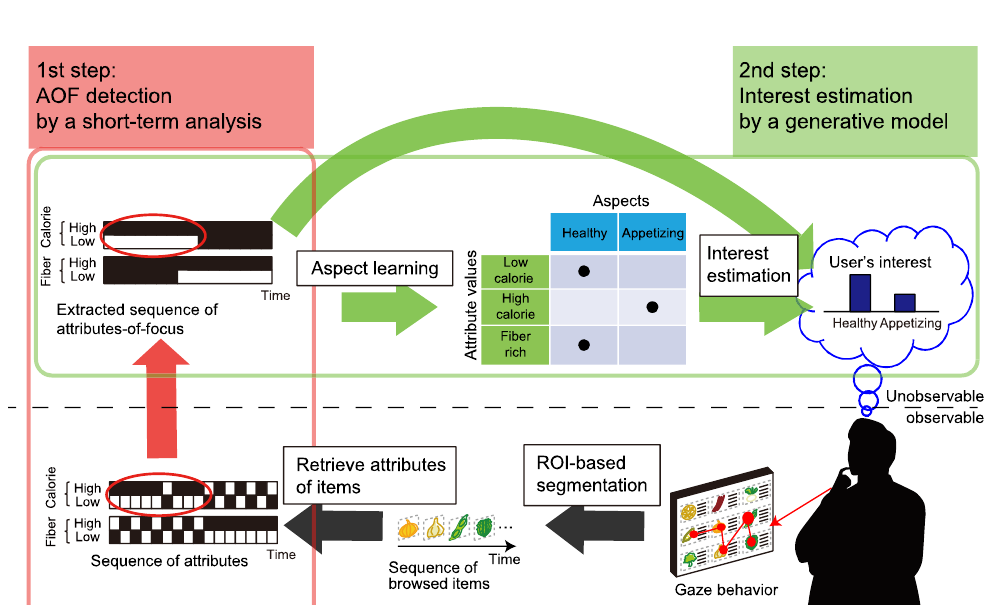
Figure 2. Flow of the two-step approach for interest estimation from user’s gaze behavior: 1st step is to detect user’s attributes-of-focus by applying likelihood-based short-term analysis; 2nd step is to estimate user interest by applying a